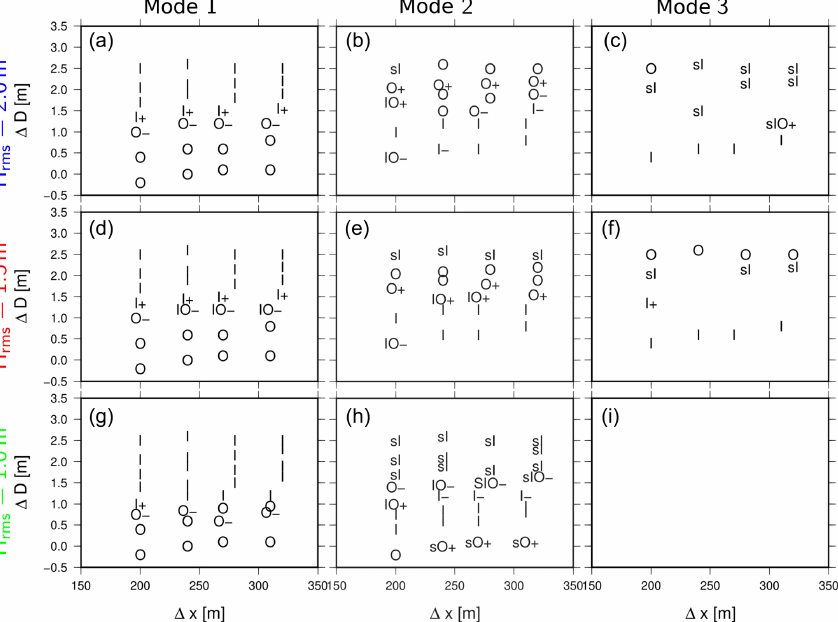
Figure 7. Morphological patterns for three unstable modes as a function of (cid:49)D and (cid:49)x . Each code represents a different pattern (detailed in Fig. 6). The top (a–c) , centre (d–f) and bottom (g–i) panels represent results obtained for a wave height equal to 1.0, 1.5 and 2.0m.